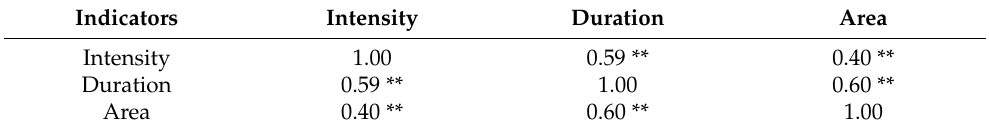
Table 6. The correlation between intensity, duration, and influence